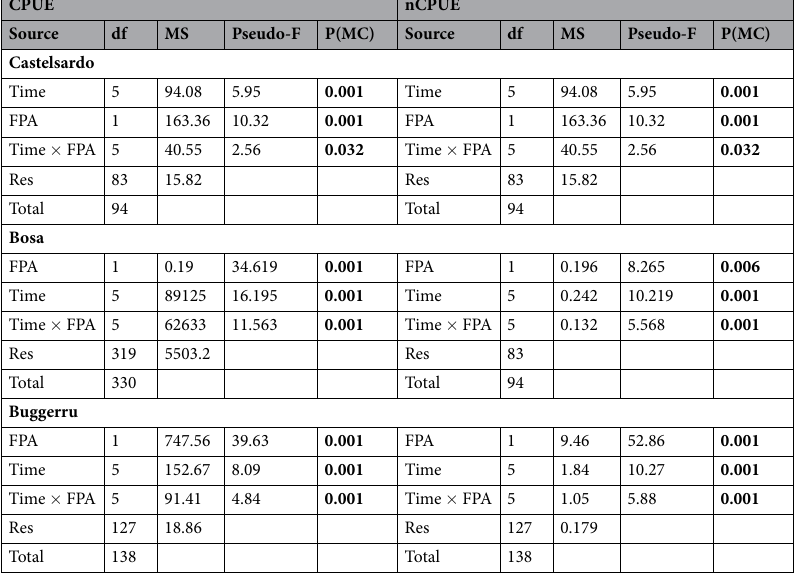
To discriminate the positive effect exerted by active restocking from the one exerted by lobsters’ protection within FPA borders, we compared both density and biomass of the inner part of Castelsardo FPA with a reference FPA where restocking was not performed (see map in Fig. 1). The forest plot produced shows the positive effect of the cumulative effect of restocking and protection, being significantly higher than the single effect provided by protection after 4 years, both for nCPUE (LnR = 1.05 ± 0.58; 95% CI) and CPUE (LnR = 0.9 ± 0.77; 95% CI